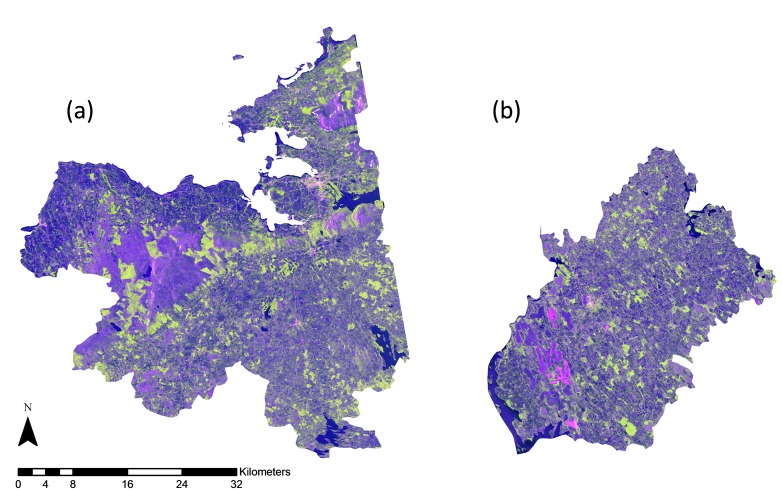
PALSAR false colour composites (HH backscatter (red)–HV backscatter (green)–HH/HV backscatter ratio (blue)) for Sligo (a), and Longford (b).(Source: European Space Agency)